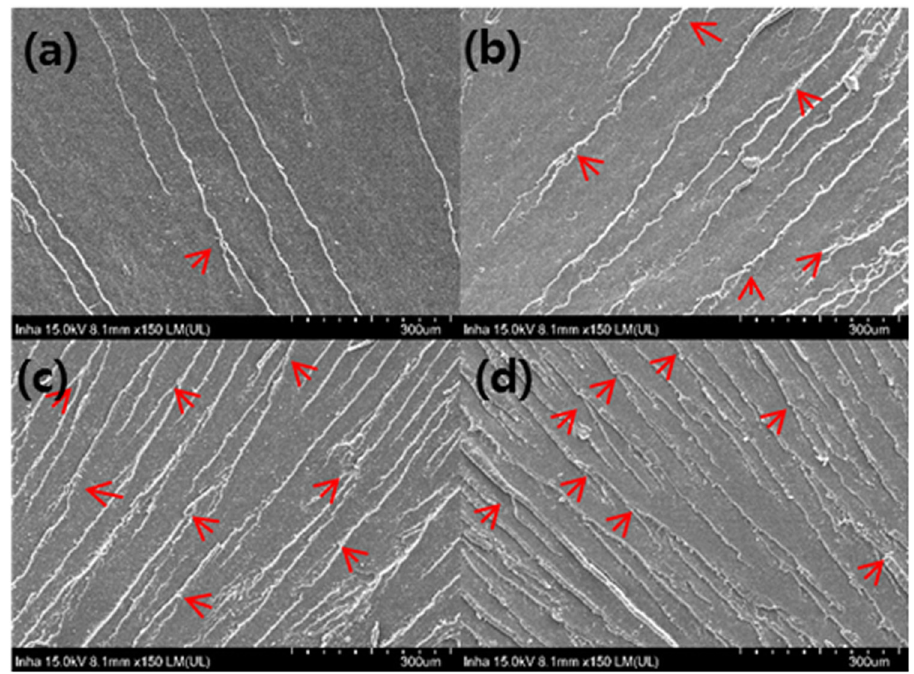
Figure 8: SEM images of the fracture surfaces: ( a ) EP/GO0.2, ( b ) EP/GO0.4, ( c ) EP/GO0.6, and ( d ) EP/GO0.8 nanocomposites.